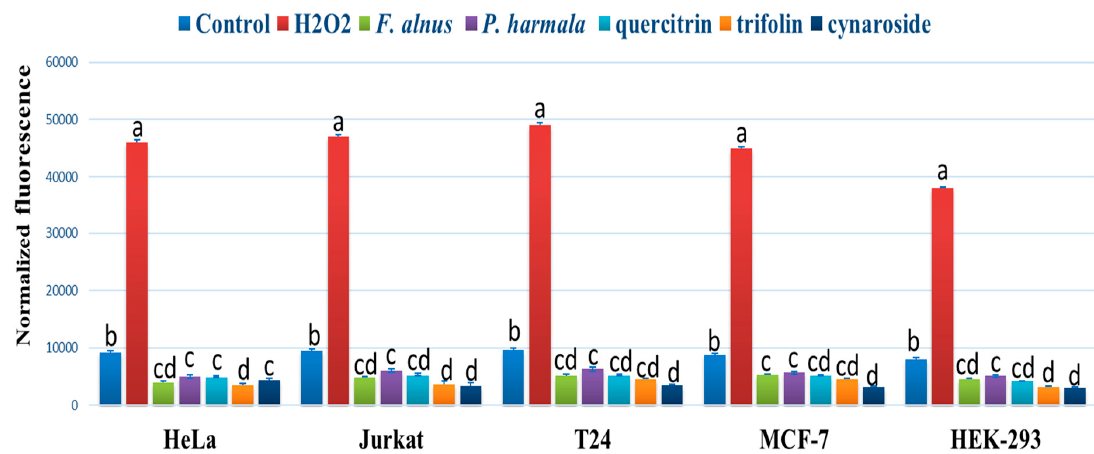
Figure 4. The effect of F. alnus and P. harmala methanolic extracts, quercitrin, trifolin, and cynaroside DPPH IC 50 on the DCF fluorescence in HeLa, Jurkat, T24, MCF-7, and HEK-293 cells. Medium with 1 mM hydrogen peroxide (H 2 O 2 ) was used as a positive control. The highest reduction of ROS was achieved using trifolin and cynaroside in all cancer cells following 90 min of incubation. The data are expressed as the mean ± SD of three experiments (four replicates per treatment). Different letters among columns in specific cells indicate significant differences at P ≤ 0.05 .